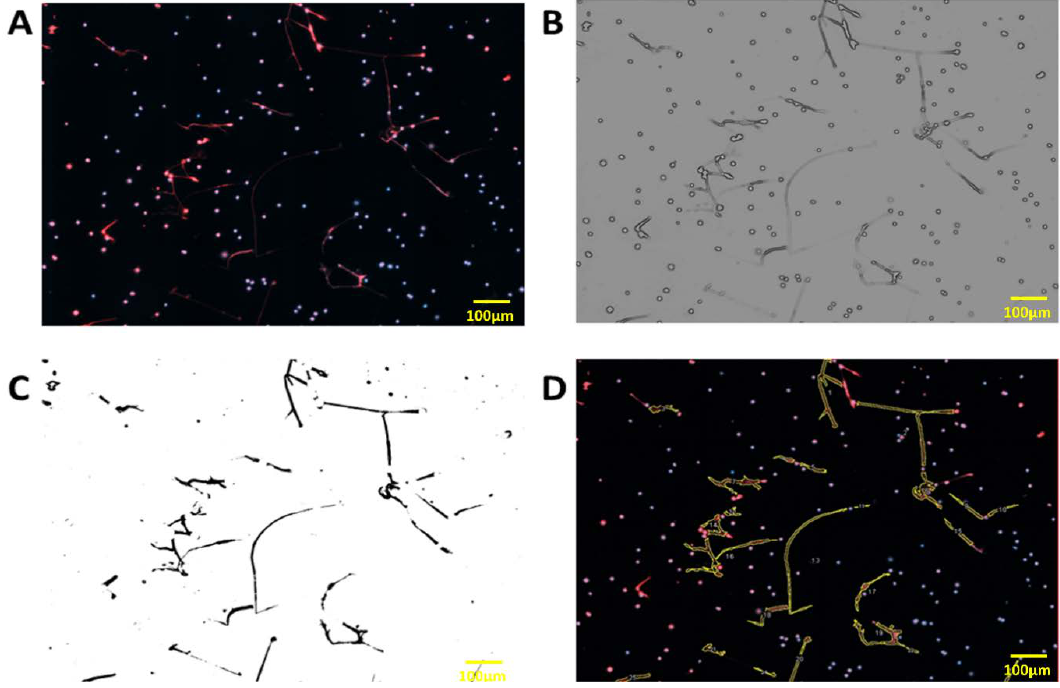
Figure A1. NETs quantification method. This method allowed for counting the total number of neutrophil nuclei, the number of DNA filaments, and the total area of NETs in the selected zone using software in ImageJ. Briefly, images obtained by fusion of Sytox Orange and Hoechst 33342 images ( A ) were blurred to enhance contrast at the edges of the NETs ( B ). Images were then inverted to suppress the Hoechst 33342 signal to exclude all nuclei ( C ). NETs highlighted were then added to the primary image for a last visual checking ( D ). Results are given in the mean number of NETs by 100 PMN and in the mean area of NETs by PMN.